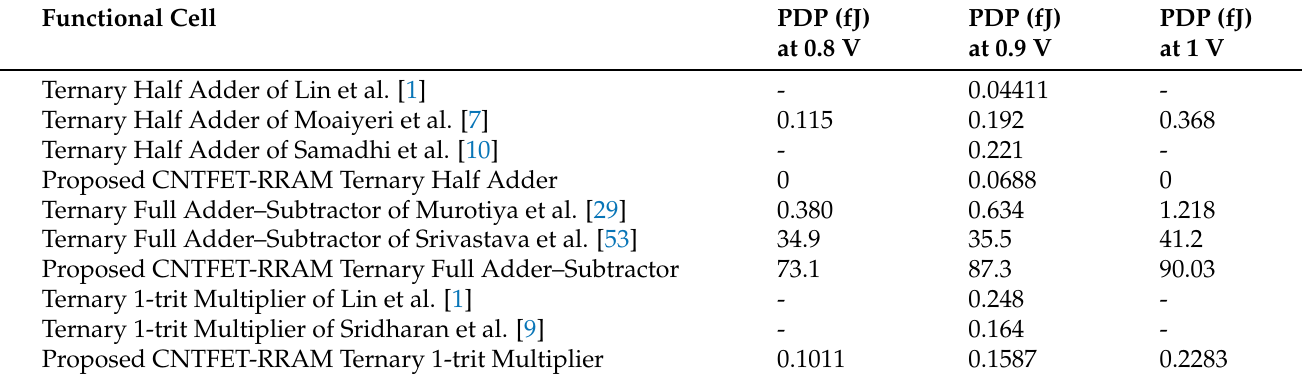
Table 7. Power delay product (PDP) comparison for the various ALU functional